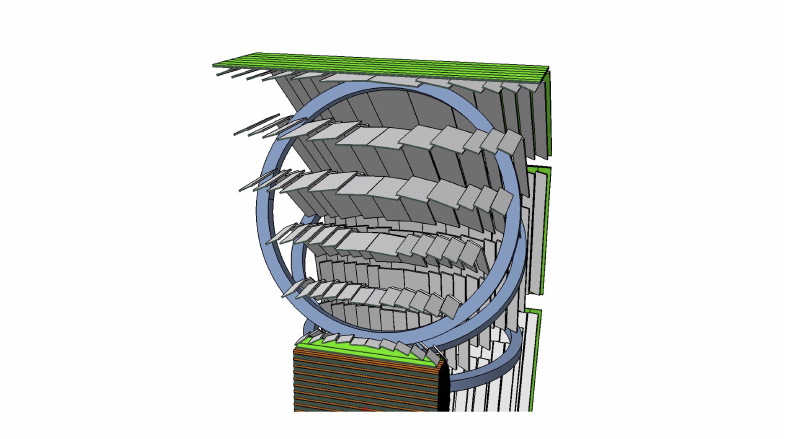
Figure 9. Detailed rendering of the silicon ladder orientation in the ALADInO tracker, optimized to reduce the occurrence of particles with large incident angles in the tracker sensor acceptance. Figure readapted from[96] under license CC BY 4.0.